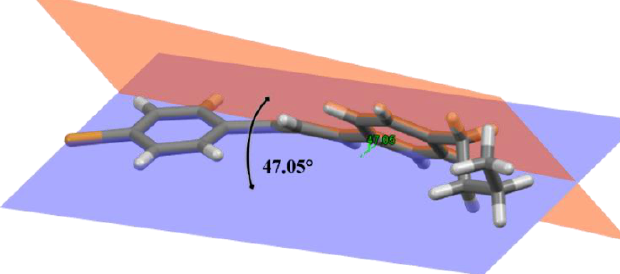
Figure 10. Illustration of the angles between rings for BBP.